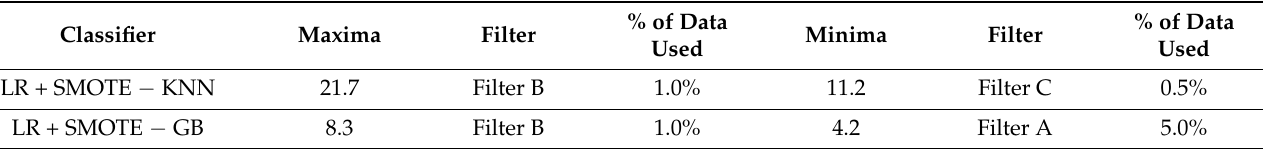
Table 3. Enrichment Ratios of ADRB2 on the original dataset with no feature selection with training size of 30%.